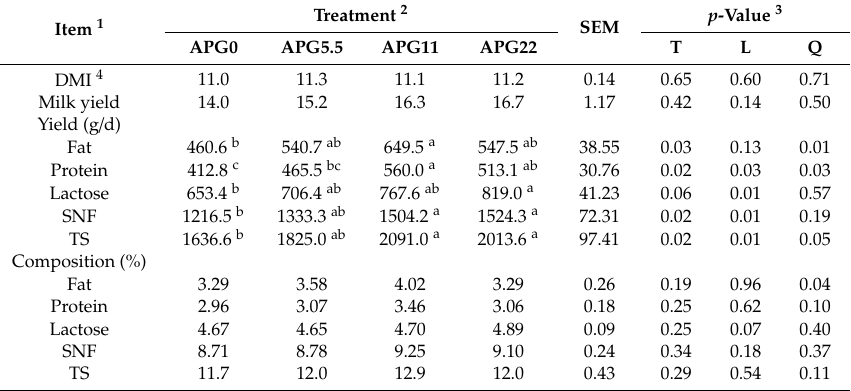
Table 2. E ff ects of APG supplementation on the lactating performance of cows. Item